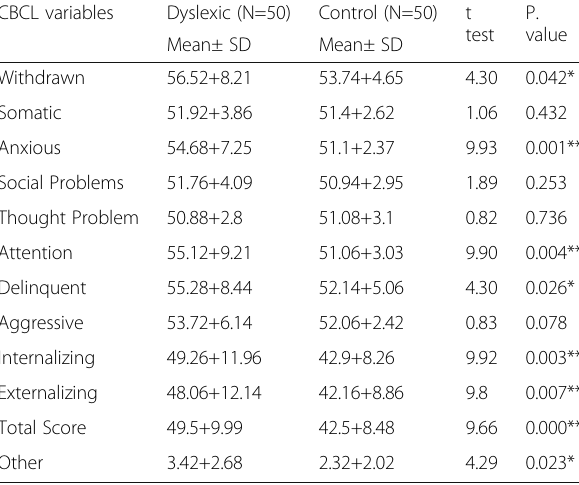
Table 6 Mean Scores of dyslexics and controls on measures of Problem Scale of